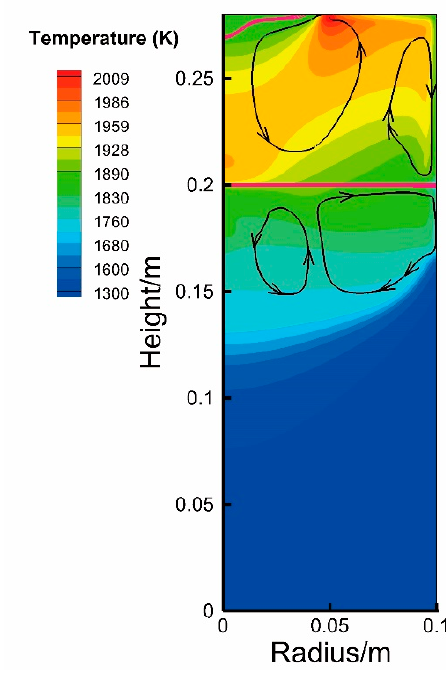
Figure 11. Predicted distribution of temperature at 2485.65 s. The red lines represent the slag/metal interface, and the black ones are streamlines.